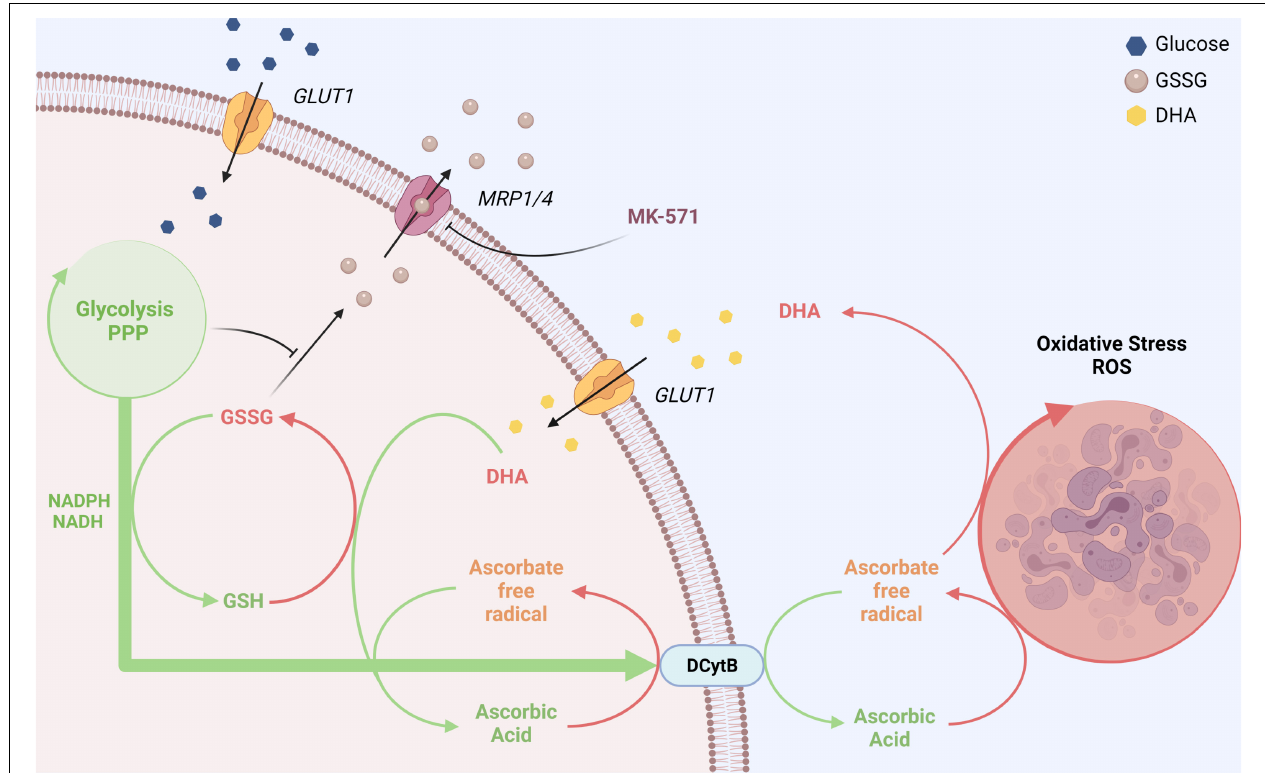
FIGURE 7 | GLUT1 and DCytb-mediated vitamin C recycling as a common feature of erythrocytes from vitamin C auxotroph mammals? The plasma membrane of human erythrocytes contains high amounts of GLUT1 and DCytb. The GLUT1 glucose transporter not only facilitates the uptake of glucose but also that of DHA, the oxidized form of vitamin C. Fast intracellular reduction of DHA to AA is ensured by high cellular GSH concentrations and the high abundance of the DHA reductase GSTO-1. Thus, spontaneous decomposition and irreversible loss of the labile DHA is prevented. DHA-dependent generation of GSSG and its export via MRP1/4 is prevented in the presence of physiological glucose concentrations. Furthermore, increased intracellular AA levels reduce intracellular ROS levels (not depicted here) and fuel DCytb-mediated plasma membrane electron transport (PMET). While in duodenal enterocytes DCytb mediates Fe 3 + reduction for dietary iron absorption, the main extracellular substrate of DCytb in the erythrocyte membrane appears to be ascorbate free radical (AFR), which is consequently reduced to AA. Both processes, (i) uptake of DHA and its intracellular reduction, and (ii) DCytb-mediated PMET activity which recycles extracellular AA from AFR (generated upon reduction of ROS in the plasma), can be considered a “vitamin C recycling mechanism.” This underestimated physiological function of human erythrocytes likely contributes to (i) oxidative stress defense in blood and (ii) sustainability of systemic AA supply, considering the fluctuating dietary uptake. The importance of this system is underlined by the finding that, in contrast to most other mammalian species, erythrocytes of vitamin C auxotroph mammals harbor GLUT1 and possibly also DCytb (see section “Discussion”). “Created with